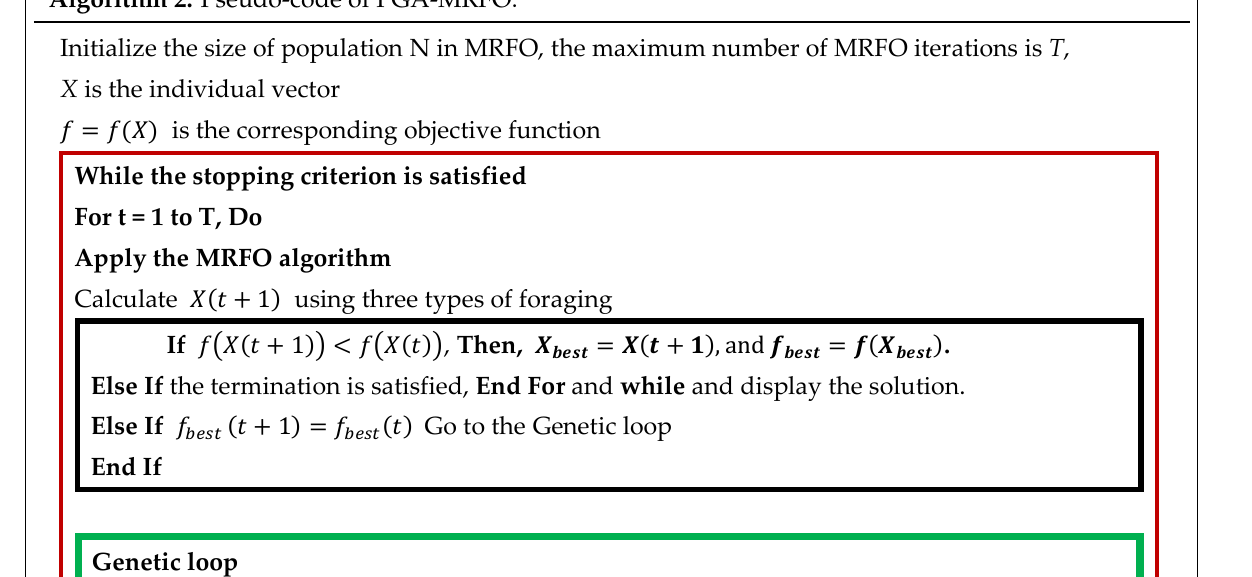
Algorithm 2. Pseudo-code of PGA-MRFO.